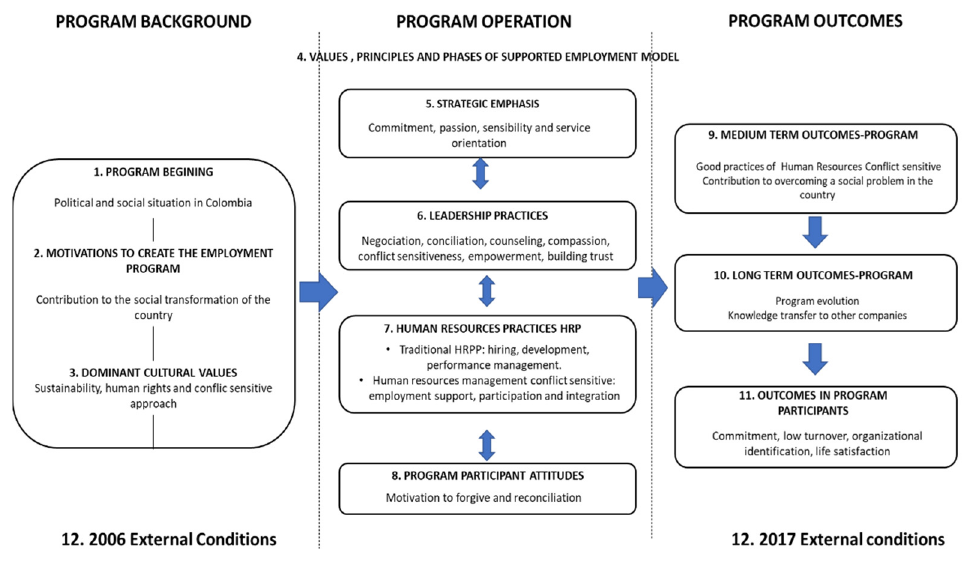
Figure 3. Work setting from the manager program perspective. Source : authors.